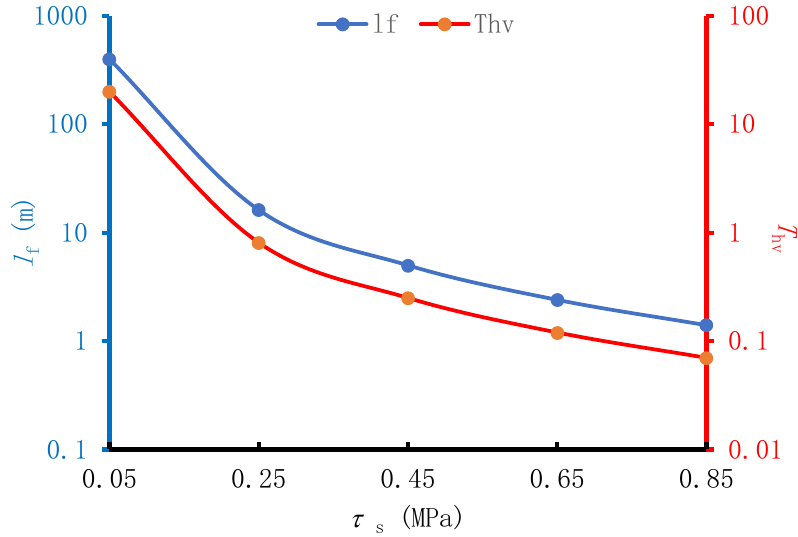
Figure 9. Changes of the length of horizontal fracture and the shape of T-type fracture with the shear strength of coalbed interface.